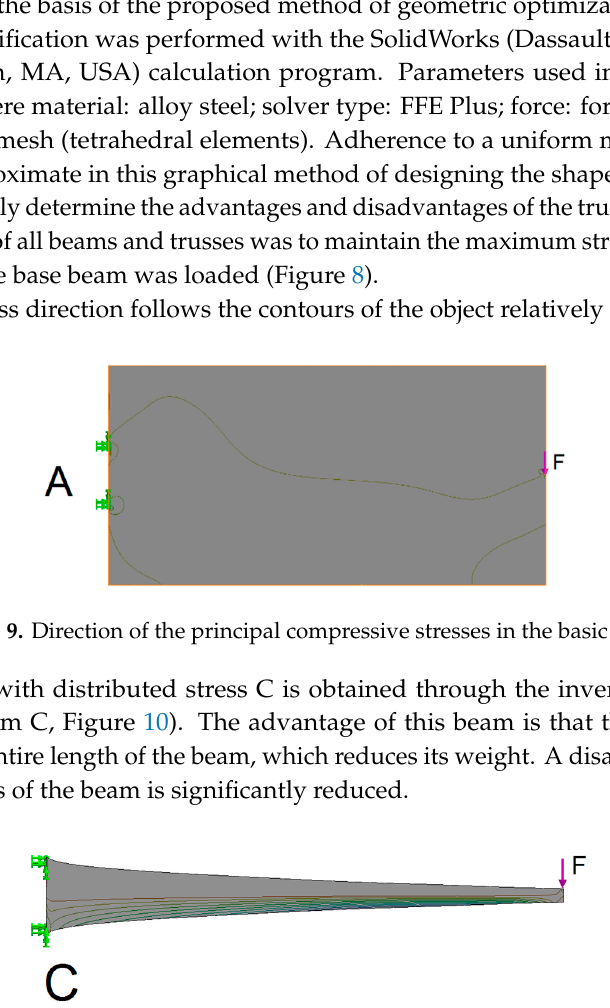
Figure 8. Load and joint of the base beam A (stress diagram).